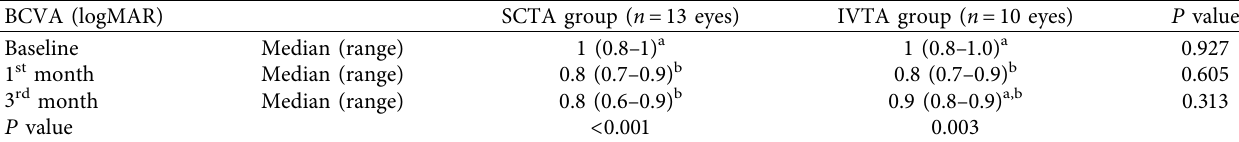
Table 2: BCVA in both groups at baseline, one month, and three months.